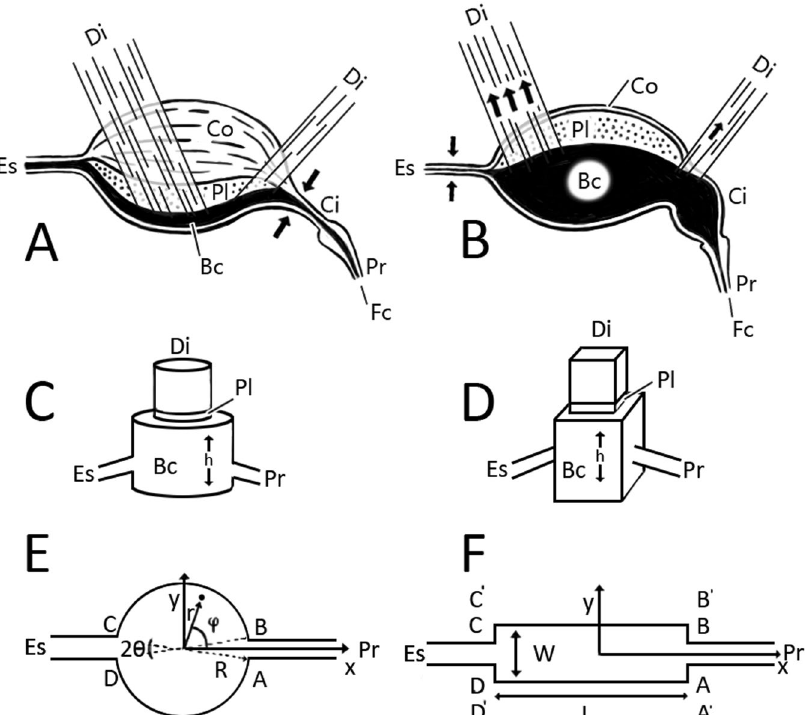
Figure 3. Schematic of lepidopteran sucking pump. ( A , B ) Lateral view of the sucking pump, consisting of the buccal chamber (Bc) and cibarium (Ci). Flow of liquid is from right to left, through the food canal (Fc) of the proboscis (Pr), into the sucking pump (Ci and Bc), and exiting via the esophagus (Es). Arrows indicate direction of muscle contraction. In ( A ), the dilator muscles (Di) have relaxed and the compressor muscle (Co) of the pump has contracted, forcing the plunger (Pl) toward the chamber floor. In ( B ), the compressor muscle of the pump has relaxed and the dilator muscles (Di) have contracted, drawing the plunger toward the dorsum of the buccal chamber. ( C – F ) Models of the sucking pump (not to scale). ( C ) The Daniel-Kingsolver model of a sucking pump. The buccal chamber is modeled as a cylindrical chamber and the circular plunger fits the chamber firmly. When the plunger moves in the vertical direction, it changes the expansion h . The proboscis and esophagus are attached to the buccal chamber. ( D ) The Bennet-Clark model of a sucking pump. The buccal chamber is modeled as a rectangular box and the plunger fits the box firmly. When the plunger moves in the vertical direction, it changes the expansion h . The proboscis and esophagus are attached to the buccal chamber. ( E ) Cirular (radius R) lengthwise cross-section of a model pump. Ratio AB/R is equal to 2 θ . The model pump has opening AB connecting the chamber with the proboscis and opening CD connecting the chamber with the esophagus. ( F ) Rectangular lengthwise cross-section of width W and length L of a model pump. Any point on the chamber floor can be specified by either Cartesian coordinates ( x , y ) for rectangular U-chambers or by cylindrical coordinates ( r , ϕ ) for circular